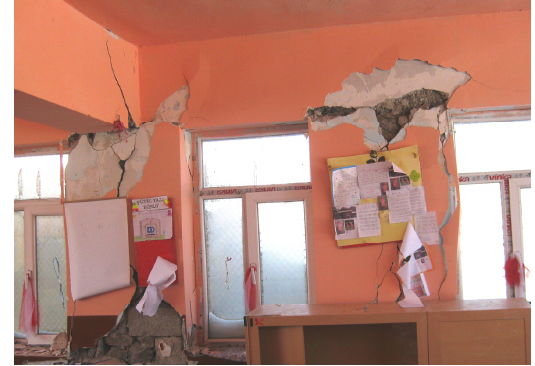
Fig. 10. Damage between two wall openings.